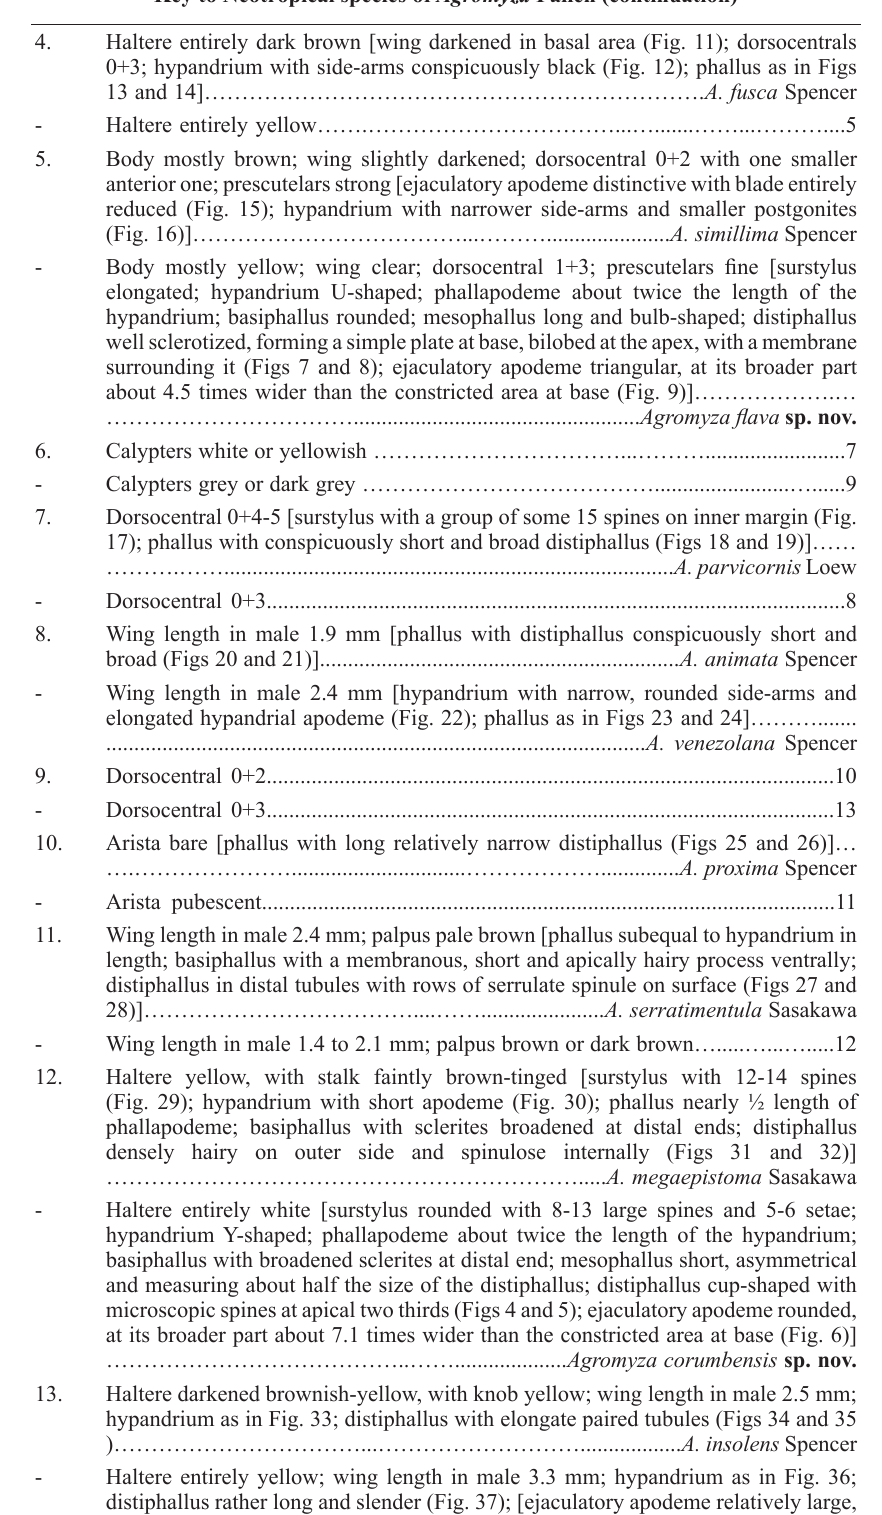
10. Arista bare [phallus with long relatively narrow distiphallus (Figs 25 and 26)]… ….…………………...............................……………….............. A. proxima Spencer 11. Wing length in male 2.4 mm; palpus pale brown [phallus subequal to hypandrium in length; basiphallus with a membranous, short and apically hairy process ventrally; distiphallus in distal tubules with rows of serrulate spinule on surface (Figs 27 and 28)]………………………………....……...................... A. serratimentula Sasakawa - Wing length in male 1.4 to 2.1 mm; palpus brown or dark brown….....…...….....12 12. Haltere yellow, with stalk faintly brown-tinged [surstylus with 12-14 spines (Fig. 29); hypandrium with short apodeme (Fig. 30); phallus nearly ½ length of phallapodeme; basiphallus with sclerites broadened at distal ends; distiphallus densely hairy on outer side and spinulose internally (Figs 31 and 32)] - Haltere entirely white [surstylus rounded with 8-13 large spines and 5-6 setae; hypandrium y-shaped; phallapodeme about twice the length of the hypandrium; basiphallus with broadened sclerites at distal end; mesophallus short, asymmetrical and measuring about half the size of the distiphallus; distiphallus cup-shaped with microscopic spines at apical two thirds (Figs 4 and 5); ejaculatory apodeme rounded, at its broader part about 7.1 times wider than the constricted area at base (Fig. 6)] 13. Haltere darkened brownish-yellow, with knob yellow; wing length in male 2.5 mm; hypandrium as in Fig. 33; distiphallus with elongate paired tubules (Figs 34 and 35 - Haltere entirely yellow; wing length in male 3.3 mm; hypandrium as in Fig. 36; distiphallus rather long and slender (Fig. 37); [ejaculatory apodeme relatively large, blade asymmetrical (Fig. 38)]………...………………........... A. plaumanni